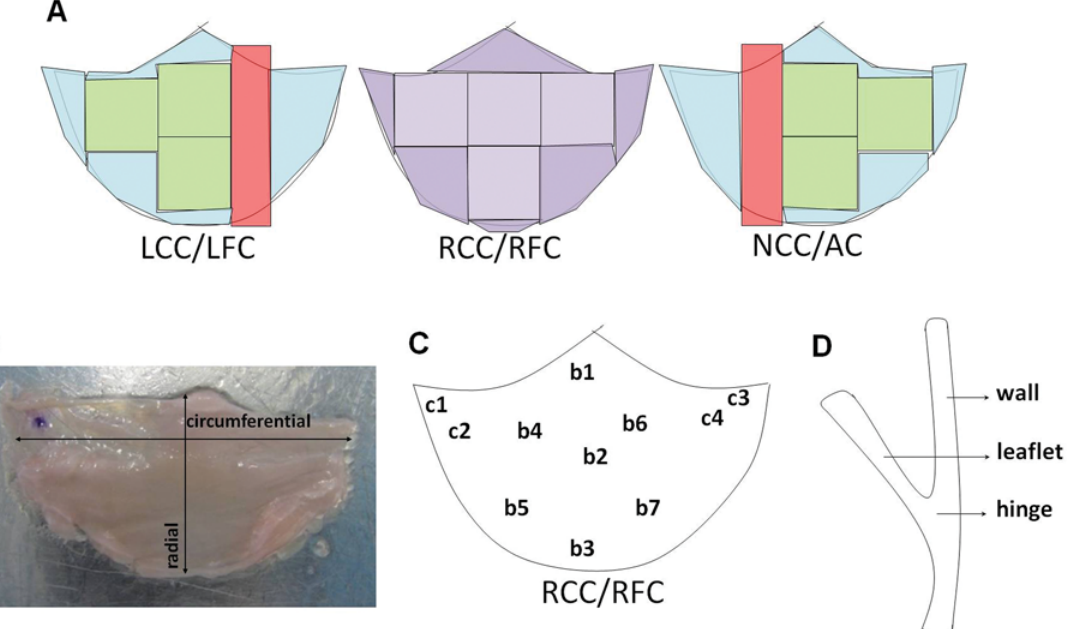
Fig 1. Schematic overview of the leaflet sectioning and assignment to the different experiments. (A) Schematic overview of sectioning of one heart valve for analyses. Samples for biaxial tensile testing are indicated in green; parts for histology in red. The right coronary cusp (RCC) and right facing cusp (RFC) were used for indentation tests (purple). Afterwards, this leaflet was used for biaxial tensile testing. Leftover tissue (blue) was freeze-dried for biochemical assays. LCC: Left coronary cusp; LFC: Left facing cusp; NCC: non-coronary cusp; AC: anterior cusp. (B) The size of the leaflets was measured in circumferential and radial direction (arrows). (C) Indentation tests were performed in the commissural (c1 – c4) and belly (b1 – b7) region of the RCC/RFC. (D) Schematic cross-section of the postnatal heart valve used for histology, depicting the wall, leaflet and hinge regions.